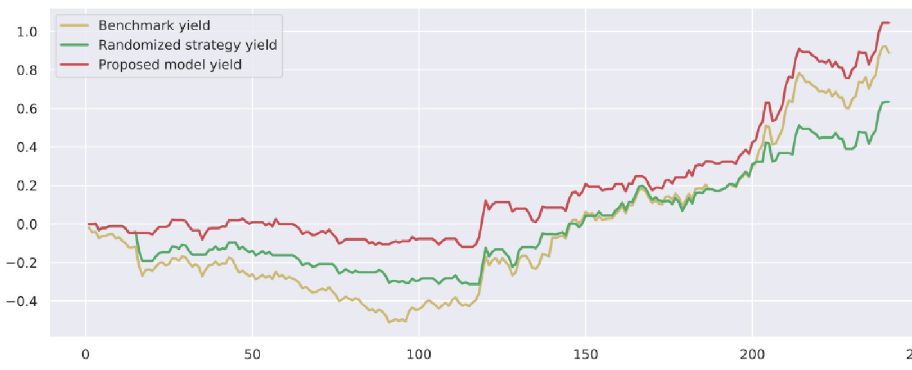
Fig 12. China Ocean holdings stock strategy returns.